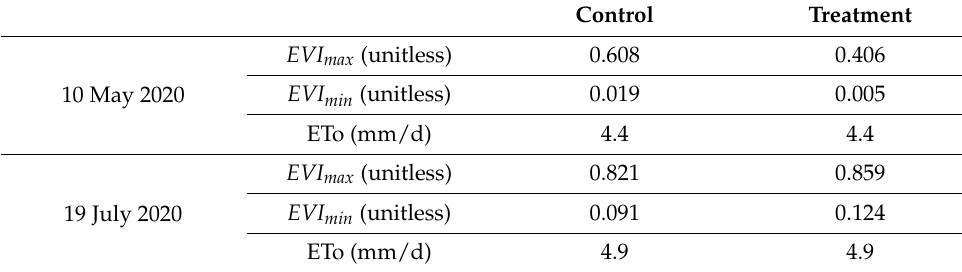
Table 7. EVImax, EVImin, and ETo, for sUAS flights on 10 May 2020 and 19 July 2020.